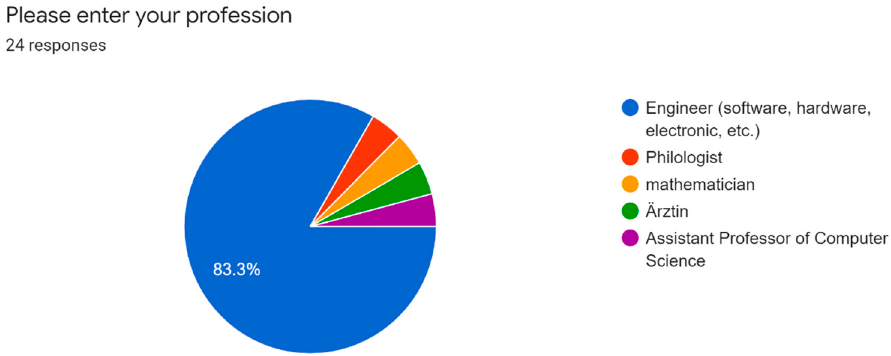
Figure 9. VoRtex test results from Google Forms report. Participant background.